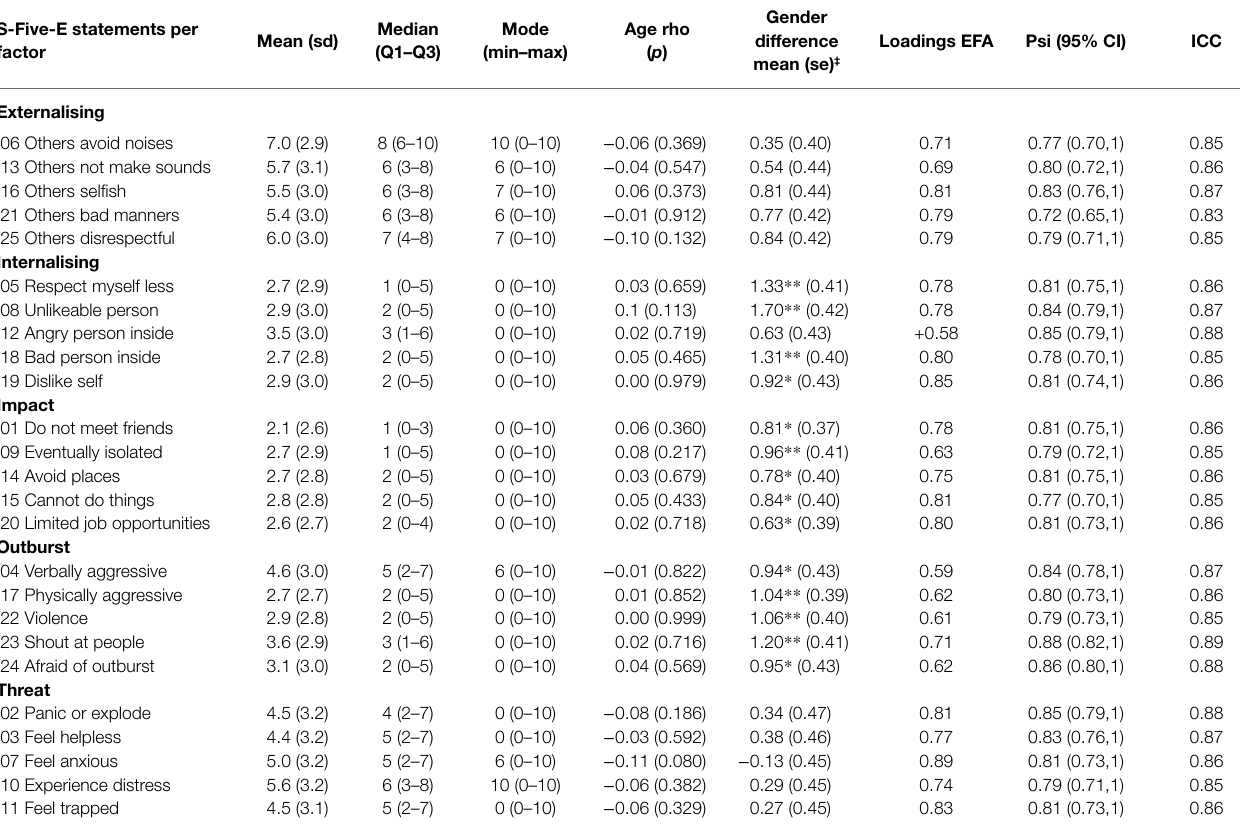
TABLE 1 | Descriptive indices, associations with age and gender, factor analysis loadings to factors, and reliability indices of the 25 S-Five items ( N =